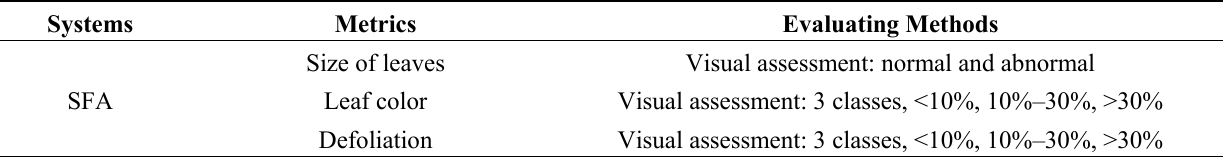
Table 9. Metrics and methods for evaluating crown conditions used in SFA [20], EU/ICP Forests [25], and FHM [26]